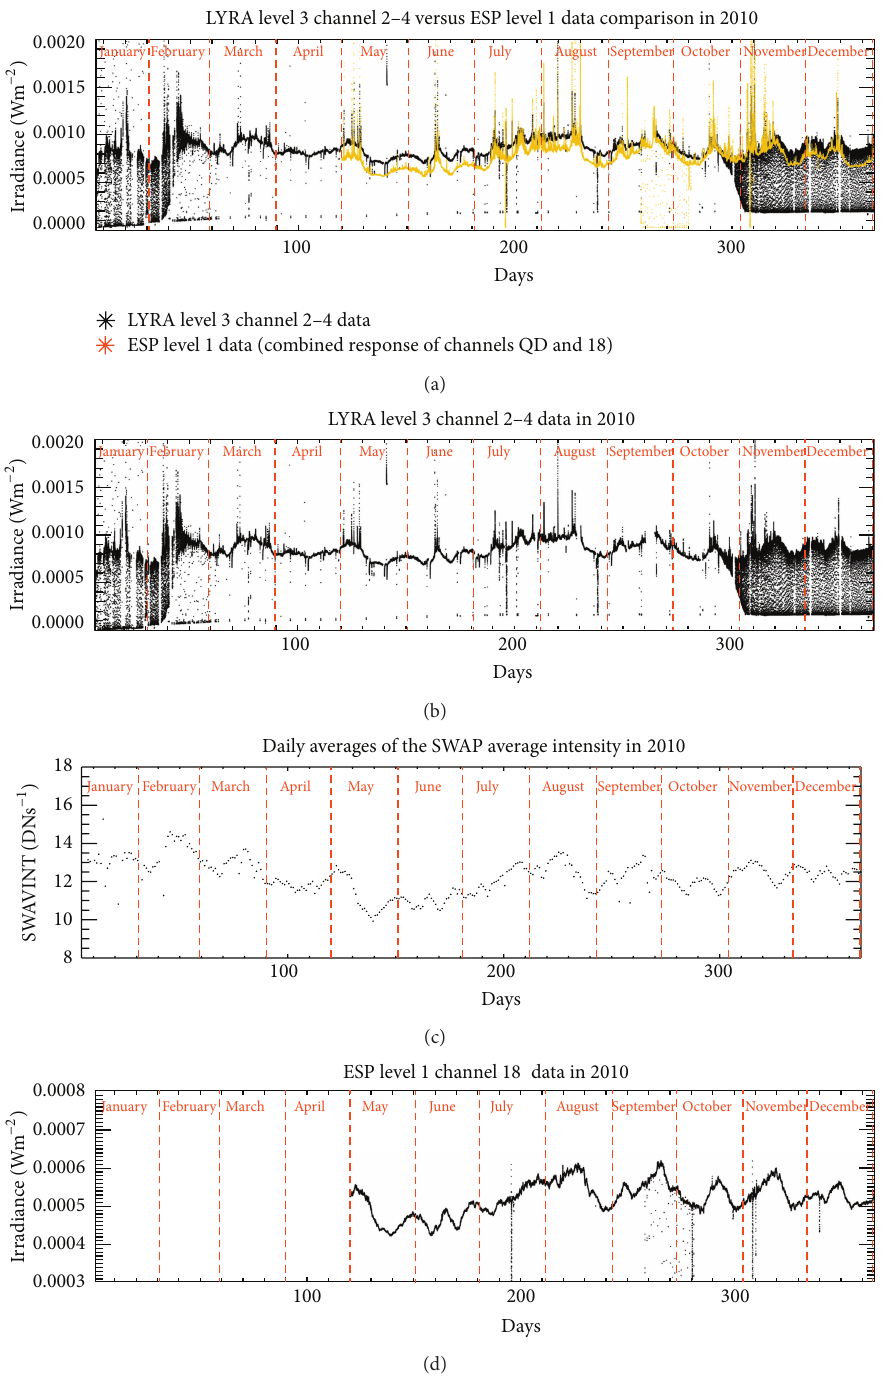
Figure 1: From top to bottom: LYRA level 3 channel 2–4 and ESP level 1 data (at combined responses of the channels QD and 18); LYRA channel 2–4 data alone; daily averages of SWAVINT data; and ESP channel 18 data variations in